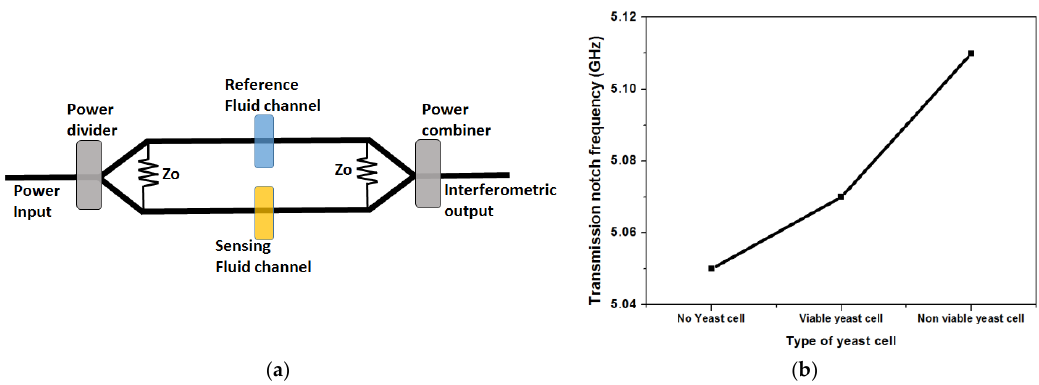
Figure 6. ( a ) Interferometric design of passive transmission lines for biosensing; ( b ) Distinction between viable and non-viable yeast cells using the interferometric approach.